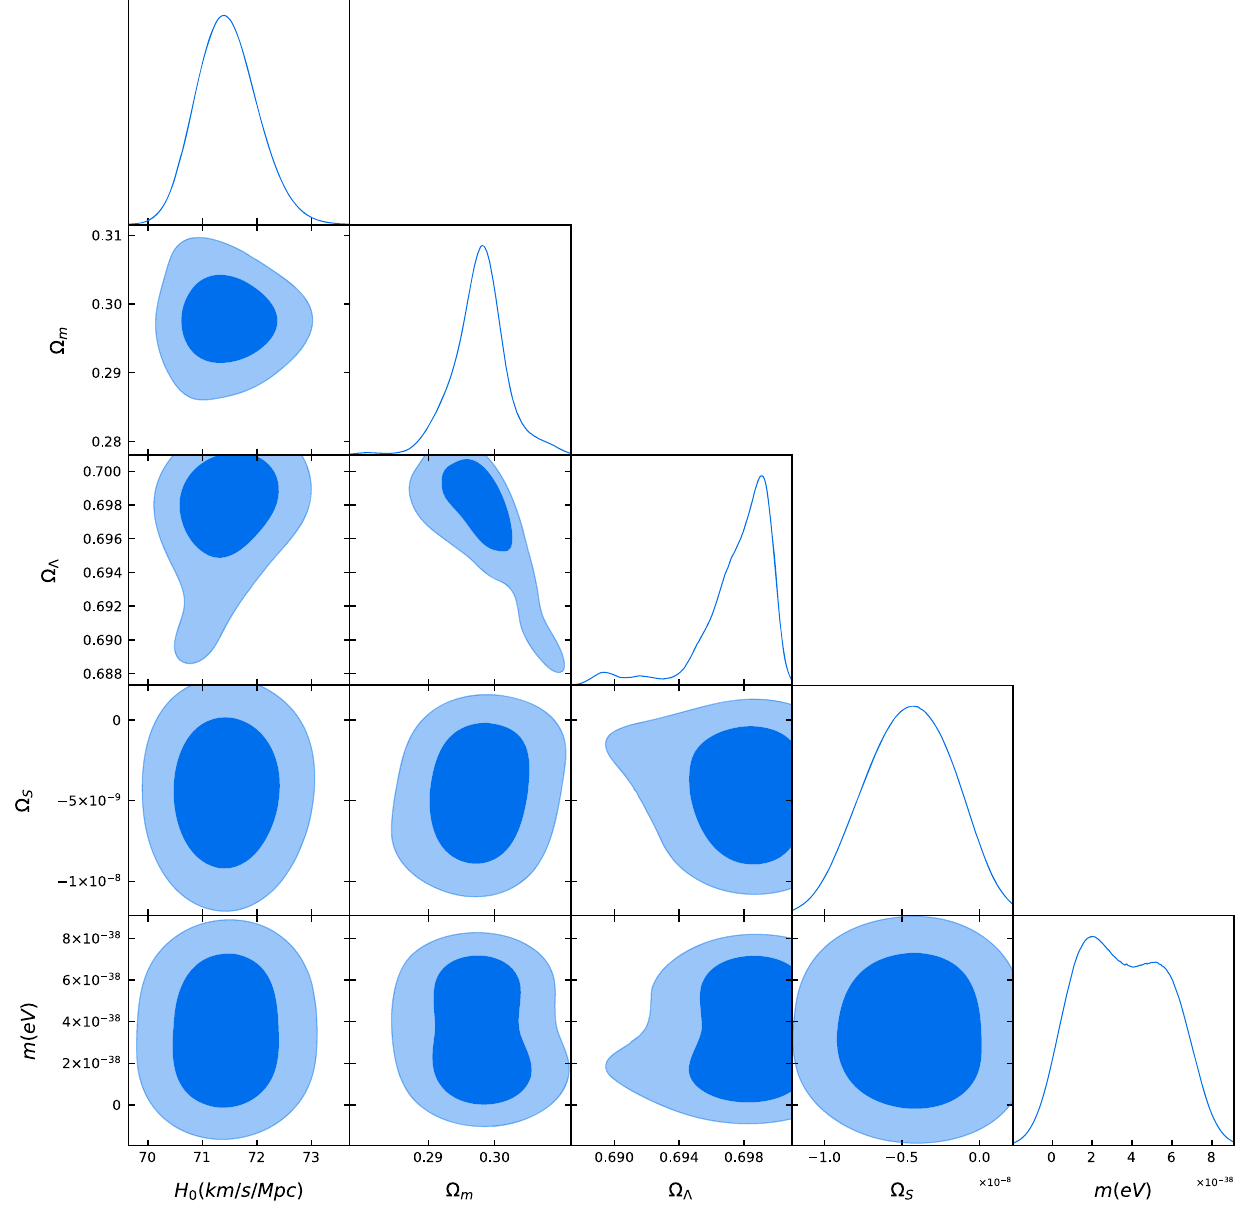
Fig. 2 The posterior distributing from the BBN + CC + SC for the torsional dark energy constraint